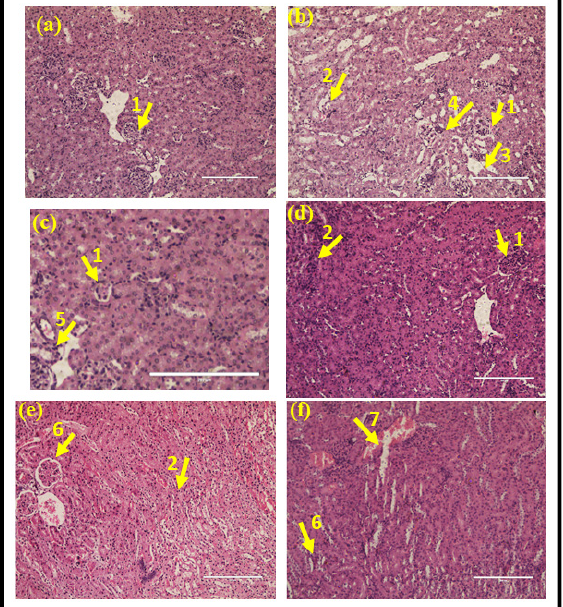
Figure 4. Histopathology analysis of kidney tissue: ( a ) normal uninfected mice (PBS), ( b ) infection control, ( c ) drug-only control ( d ) heraclenol treatment group at below MIC, ( e ) heraclenol treatment group at MIC value, ( f ) heraclenol treatment group at above MIC. 1: inflammation, 2: congestion, 3: dilation of Bowman’s capsule, 4: glomeruli congestion, 5: loss of tubular structure, 6: normal glomeruli, and 7: chronic inflammation.